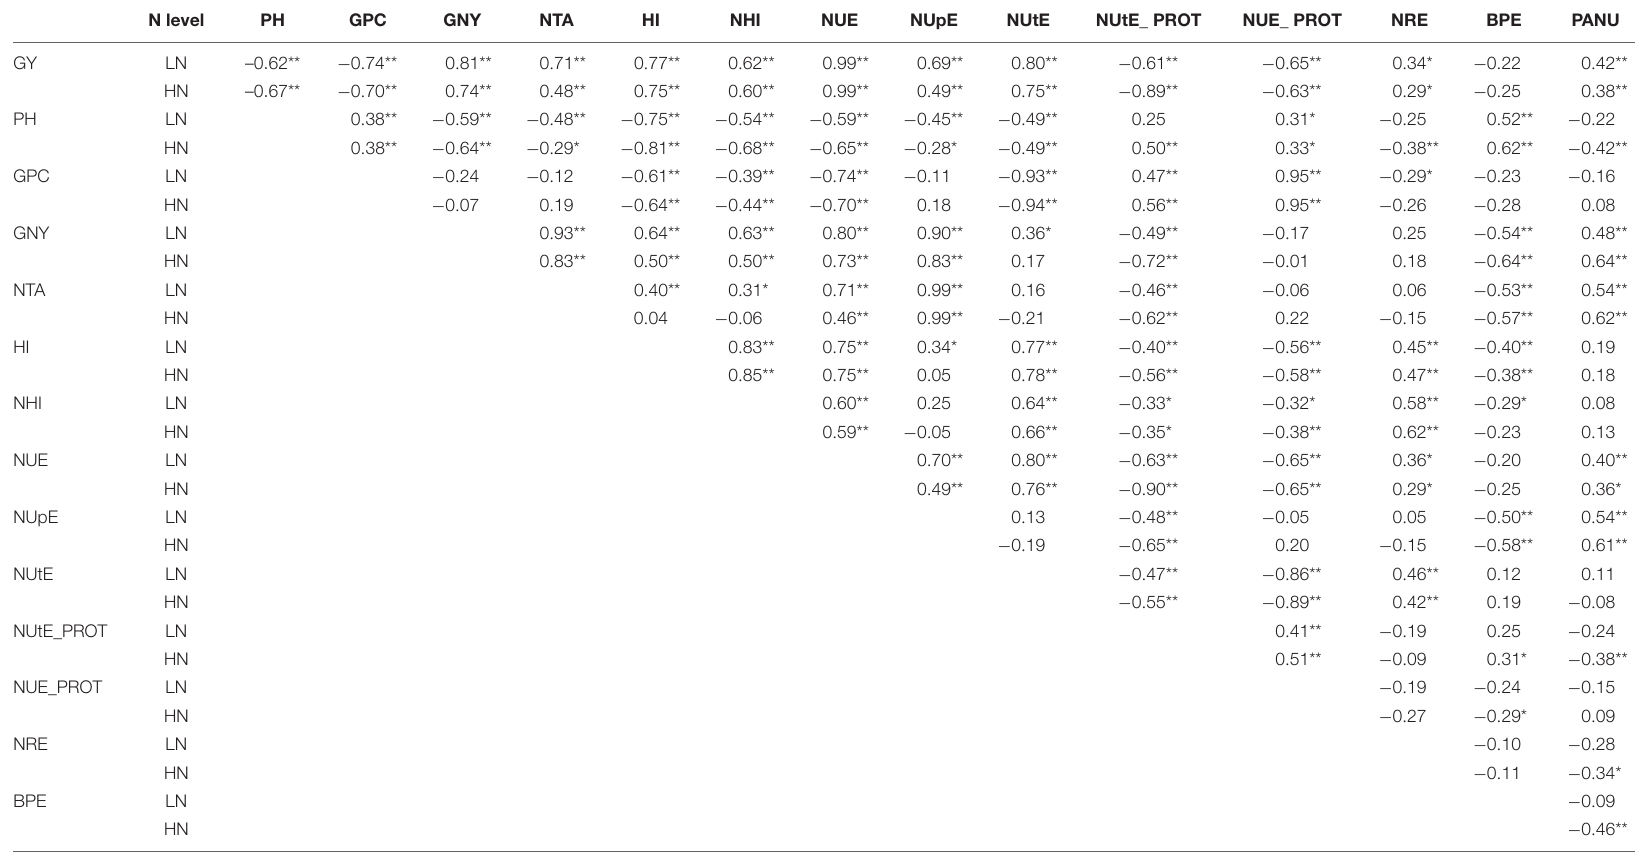
TABLE 2 | Linear correlations ( r ) between analyzed traits at low (LN) and high (HN) nitrogen levels across environments ( n = 48